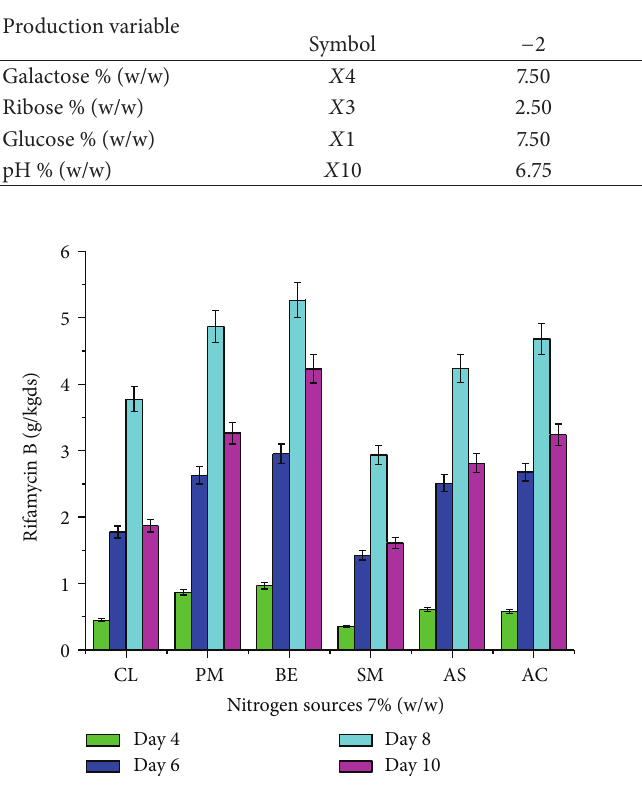
Figure 3: Effect of various concentrations of barbital (% w/w) on rifamycin B production by Nocardia mediterranei MTCC 14 using sunflower oil cake under solid-state